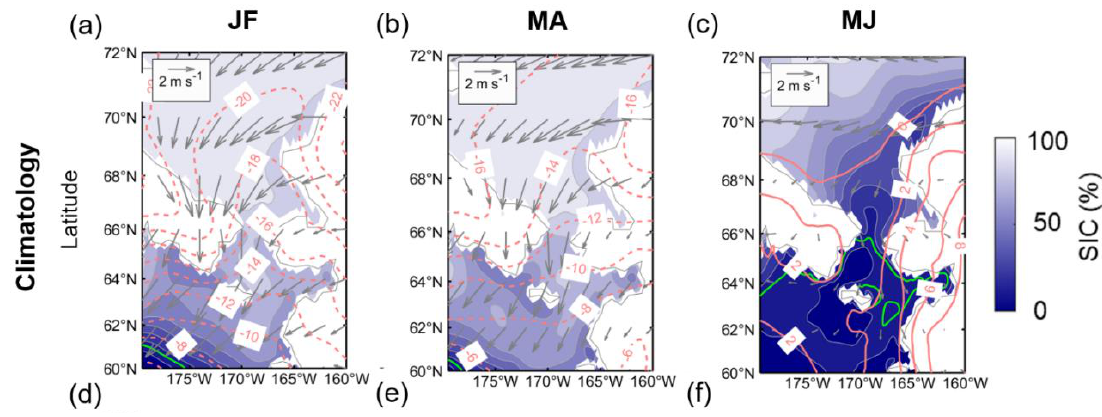
Figure 4. ( a – c ) Two-monthly composite climatology for SIC (color shading), T2M (red contours), and 10-m wind field (gray vectors) during January-June. Two-monthly composite anomalies for ( d – f ) 2018 and ( g – i ) 2019 for SIC, T2M, and wind field. The solid green line indicates marginal sea ice edge (SIC = 15%). Solid (dashed) lines indicate the positive (negative) contours of T2M. Figure 5 shows the distribution of Chl-a during the early spring (March to April), late spring (May to June), and summer (July to August) seasons, including the positions of the marginal sea ice edges. In March and April 2018, the ice edge receded far from the clima- tological ice edge position, and most of the northern Bering Sea was exposed to the atmos- phere (Figure 5a). Nevertheless, phytoplankton biomass was at a level similar to that of normal years. A weak positive Chl-a anomaly patch existed only in part of the eastern Bering shelf. Instead, due to the substantial displacement of the ice edge, a strong negative anomaly was observed for both years in the areas associated with the bloom that had pre- viously appeared in the marginal sea ice zone (near climatological ice edge). The spatial distributions of the Chl-a anomaly and open water in March – April 2019 are not substan- tially different from those in 2018 (Figure 5b). However, the eastern Bering shelf exhibited the opposite Chl-a anomaly pattern (Figure 5c). The rapid ice retreat and high positive Chl-a anomaly were observed in May – June as a result of weakened wind forcing, warmer temperature (Figure 4c), and a seasonal increase in solar radiance [25]. In 2018, a